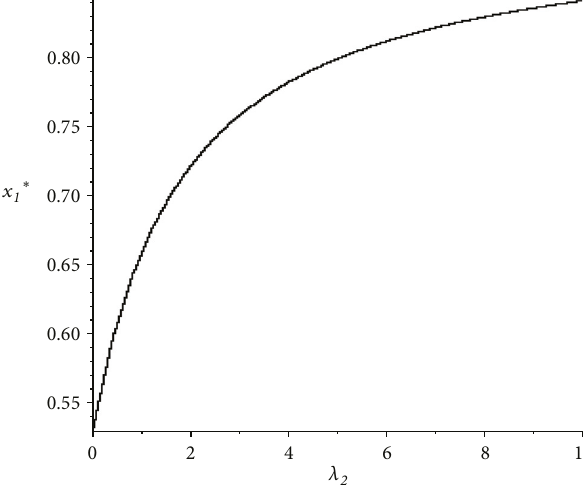
Figure 3: The changes of equilibrium share of player 1 as 𝜆 2